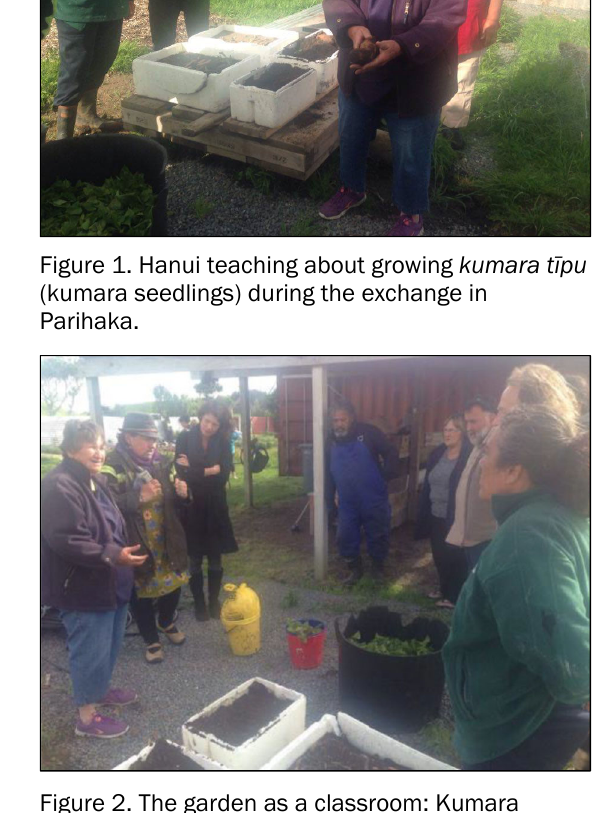
Figure 3. From left: Lisa Isherwood, Karyn Stein, Arohanui (Hanui) Lawrence, Ellen Baldwin, and Lisa’s daughter Mary-Blossum in front of Te Whiti’s statue in Parihaka.